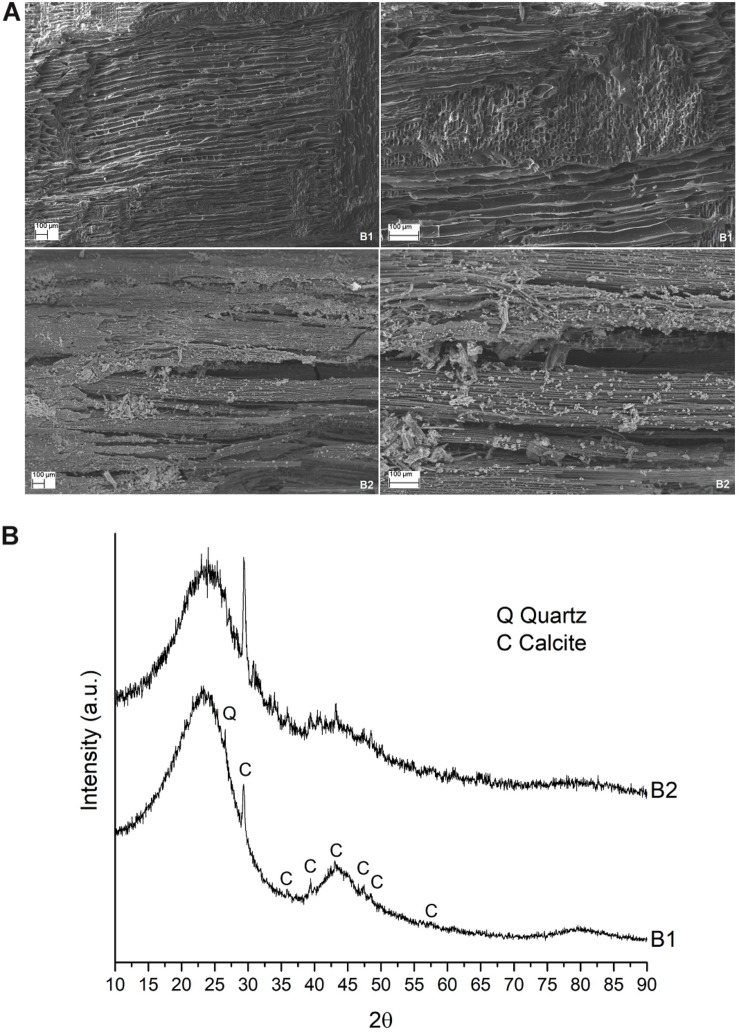
(A) Microstructure of the two biochars used. a SEM images of biochar B1 (up) and B2 (down), 100X and 250X on the left and right side, respectively. (B) X-ray diffraction pattern of the two biochars.